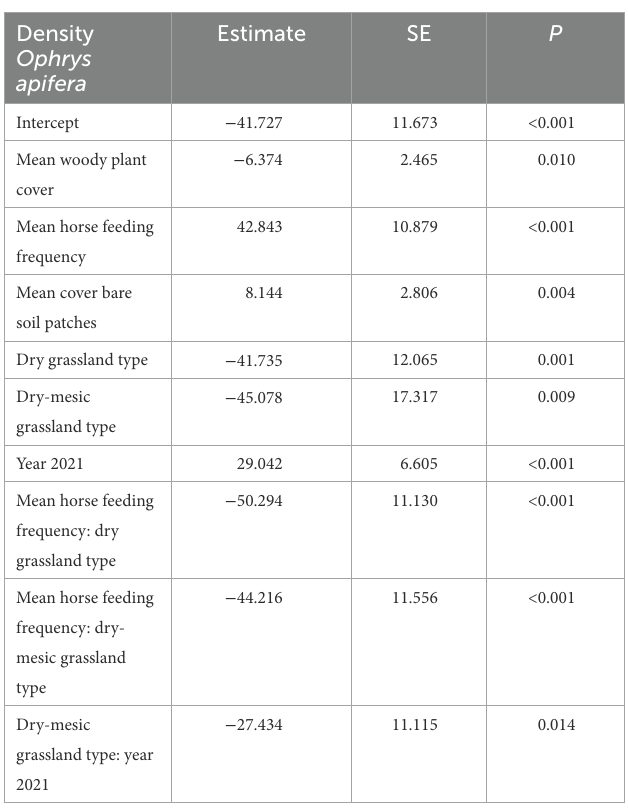
TABLE 1 Results of the linear mixed-effect model for effects of horse feeding frequency, woody plant cover, bare soil patches, year (three-level factor) and grassland type (three level factor) on density of the target orchid species Ophrys apifera